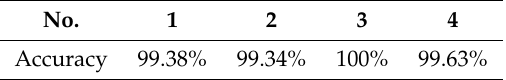
Table 3. The accuracy of mode